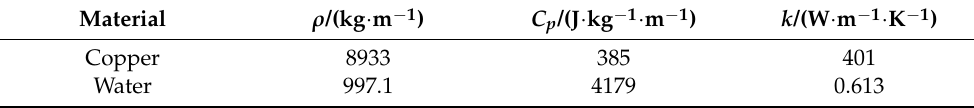
Table 2. Water and copper thermo-physical characteristics